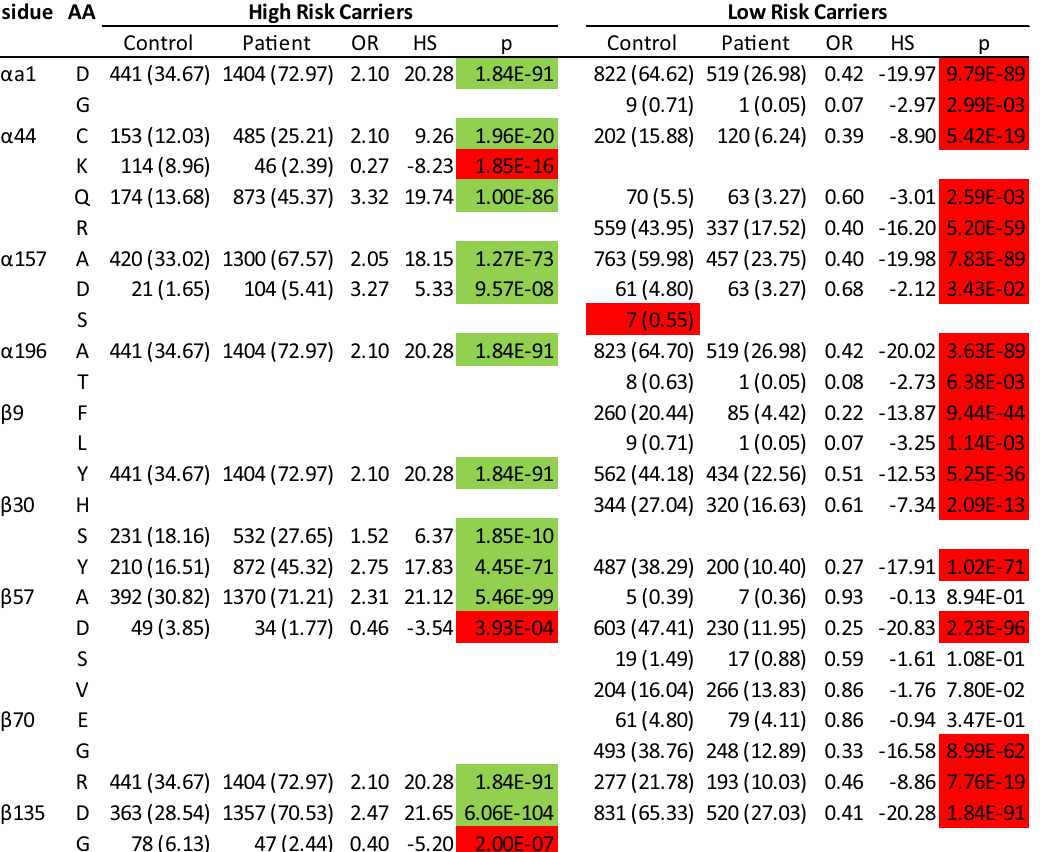
Table 1. Results from association analysis of nine selected residues (αa1, α44, α157, α196, β9, β930, β57, β70, β135) with T1D in the case-control study with 636 control and 962 patients with estimated allelic frequencies (%), odds ratio, hap-score and p-value among carriers of DQ2.5 and DQ8.1 and